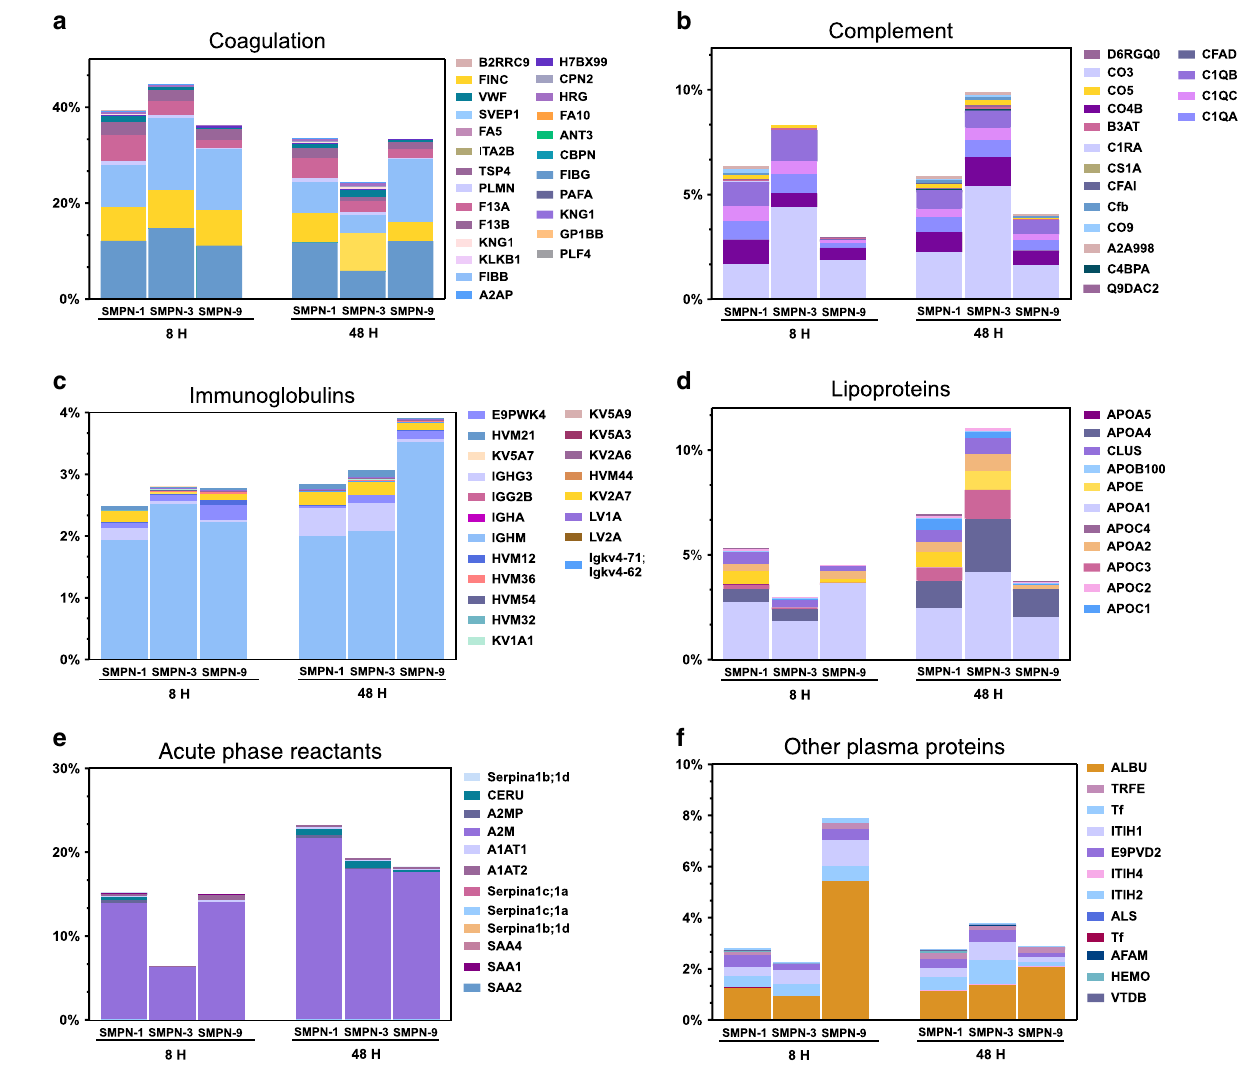
Fig. 5 Classi fi cation of adsorbed proteins with respect to their biological function. Abundance of protein groups as the percentage of total proteins on SMPNs classi fi ed based on their biological activity on various SMPNs at 8 and 48 h; a coagulation proteins, b complement proteins, c immunoglobulins, d lipoproteins, e acute phase reactants, and f other plasma